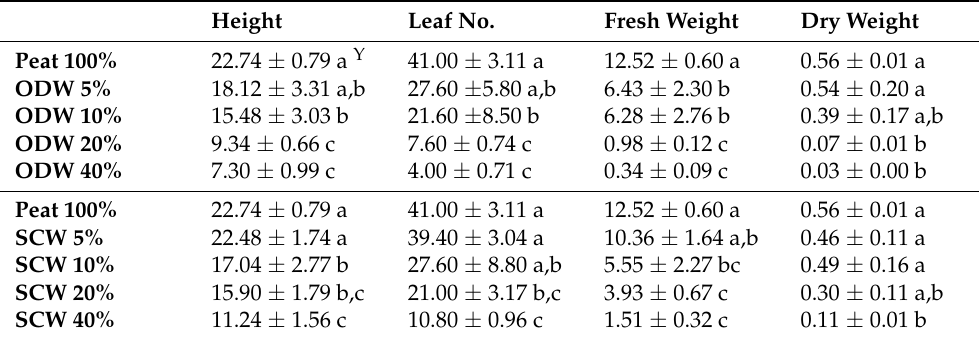
Table 3. Impact of growing media (peat; Origanum dubium waste—ODW; Sideritis cypria waste—SCW) on purslane seedlings’ height (cm), leaf number, upper part fresh weight (g/plant), and dry weight (g/plant) on plants grown in greenhouse/nursery.